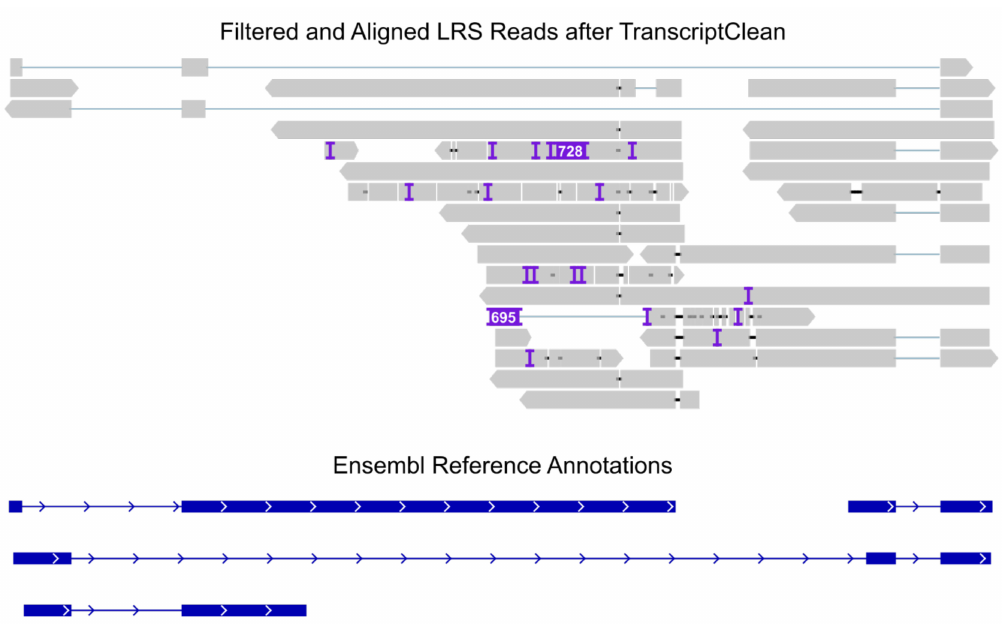
Figure 4. TranscriptClean generates polished reads that permit a cleaner alignment. Alignment of Shark-filtered reads to the LINC00173 locus after processing by TranscriptClean and compression by SAMtools. Processed reads are shown in gray; transcripts currently annotated in Ensembl are shown in blue. Image generated with IGV.